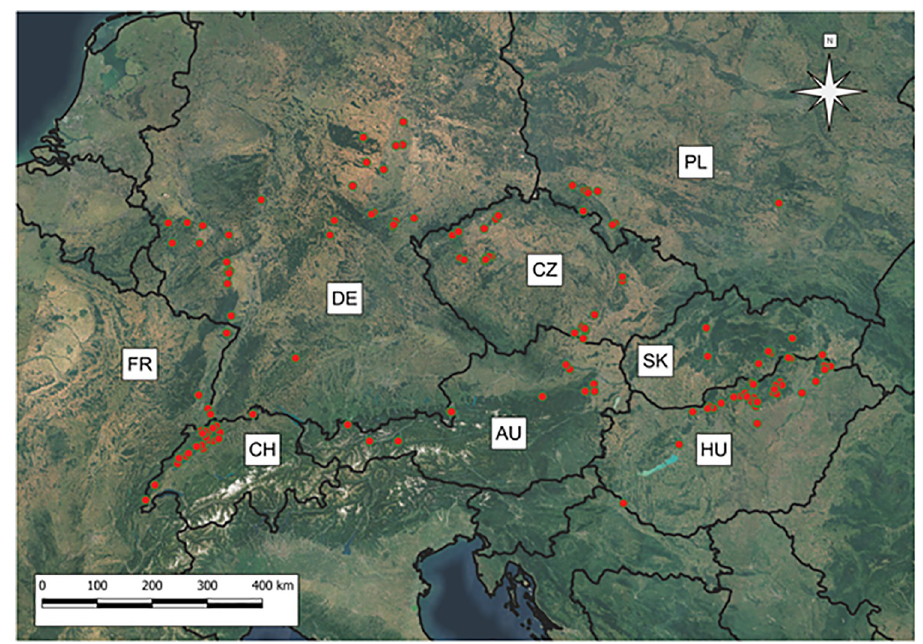
Fig 1. Location of study sites. Red dots indicate the distribution of the analyzed releve´s of natural, rocky scrub communities across Central Europe ( n = 387). Explanation of the abbreviations used: AU–Austria, CH–Switzerland, CZ–Czech Republic, DE–Germany, FR–France, HU–Hungary, PL–Poland, SK–Slovakia. Black contour lines–national boundaries. The map was made with Natural Earth. Free vector and raster map data @ naturalearthdata.com, © MapTiler, © OpenStreetMap